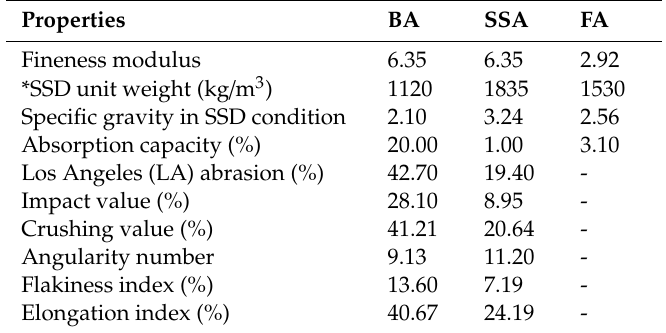
Table 4. Physical properties of coarse (SSA and BA) and fine (FA)